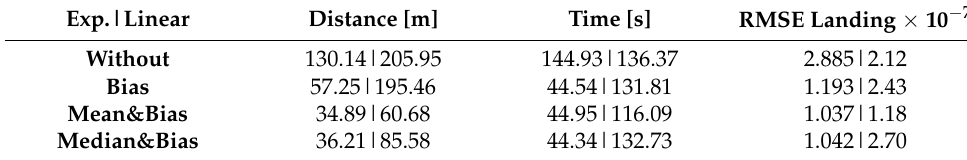
Table 7. Median value of quality